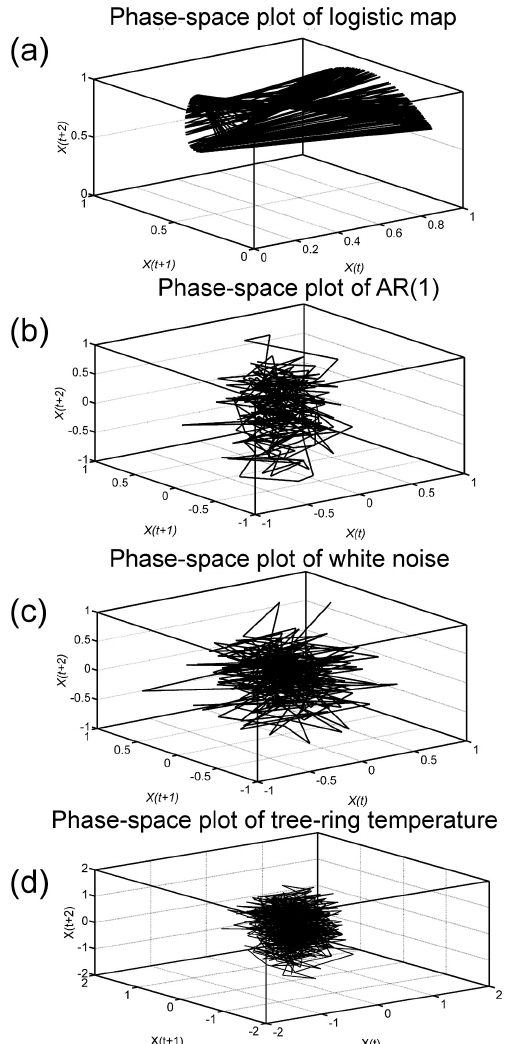
Fig. 1. (a–c) show phase diagram of non-stationary, nonlinear and random characteristics of different types of synthetic time series, re- spectively. (d) 3-D scatter plot of actual tree-ring temperature time series. The data characteristics apparently show that the tempera- ture record is non stationary (between stochastic and